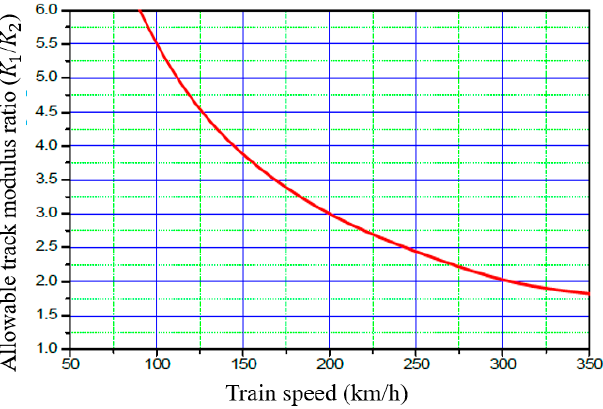
Figure 1. The allowable ratio of the track modulus difference depending on train speed [19].